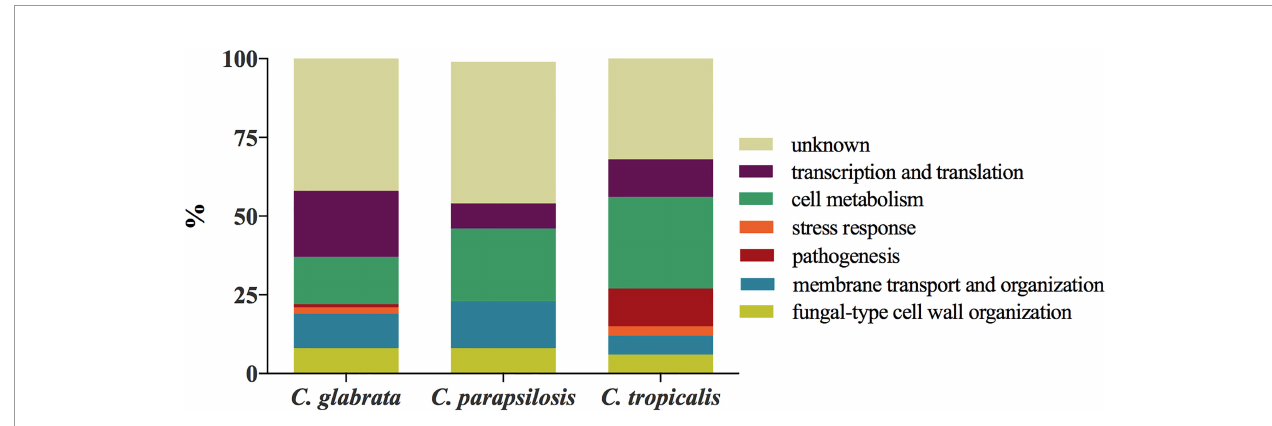
FIGURE 3 | Functional classi fi cation of proteins identi fi ed for C. glabrata , C. parapsilosis , and C. tropicalis bio fi lm-originated